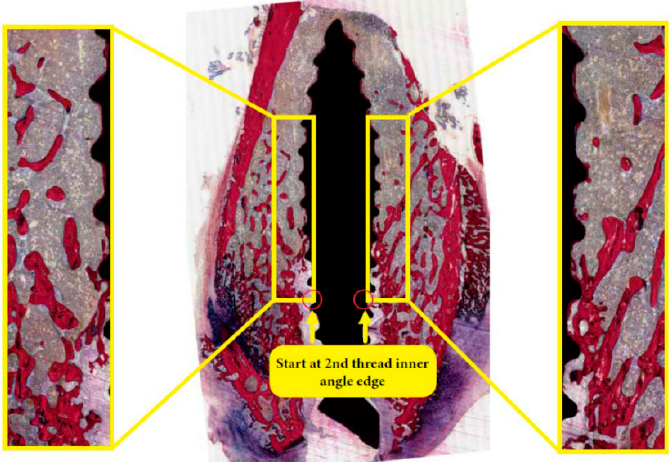
Figure 1. Sequence of representative histological sections (stained with methylene blue and basic fuchsin) showing the region of interest (ROI) for the measurement of bone area (BA%) and bone-to-implant contact (BIC%): from the left and right sides of the implant (yellow box).